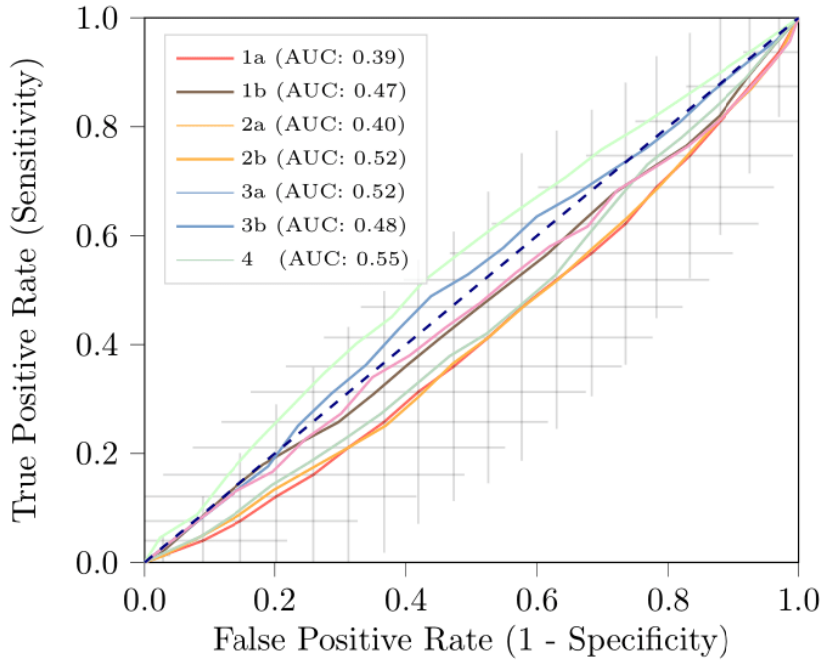
Figure 5. Receiver operating characteristic curves of the radiomics models in the testing datasets based on: (1a) all lymph nodes—features combined over all nodes; (1b) all lymph nodes—mean of features per lymph node; (2a) lymph nodes > 15 mm—features combined over all nodes; (2b) lymph nodes > 15 mm—features combined over all nodes; (3a) largest five lymph nodes—features combined over all nodes; (3b) largest five lymph nodes—features combined over all nodes; and (4) features extracted from the largest 2D cross-sectional area of the primary tumor. The curves represent the mean of the 100 × random-split cross-validations; for Model 1a, 95% confidence intervals are represented by the crosses.